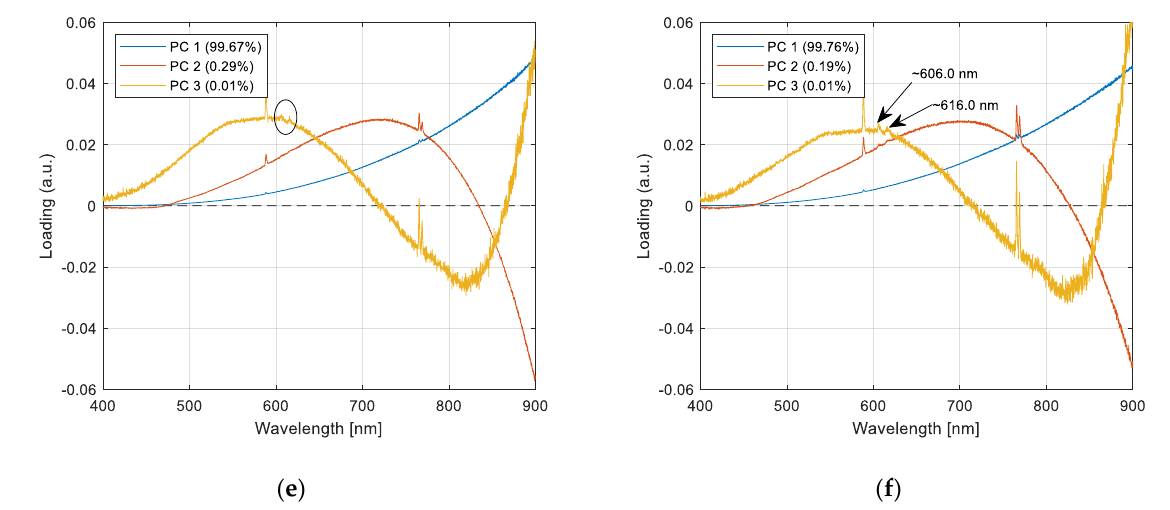
Figure 4. PCA analysis on the combustion spectrum of chalcopyrite of different sizes. ( a ) CpyA, ( b ) CpyB, ( c ) CpyC, ( d ) CpyD, ( e ) CpyE, ( f ) CpyF.